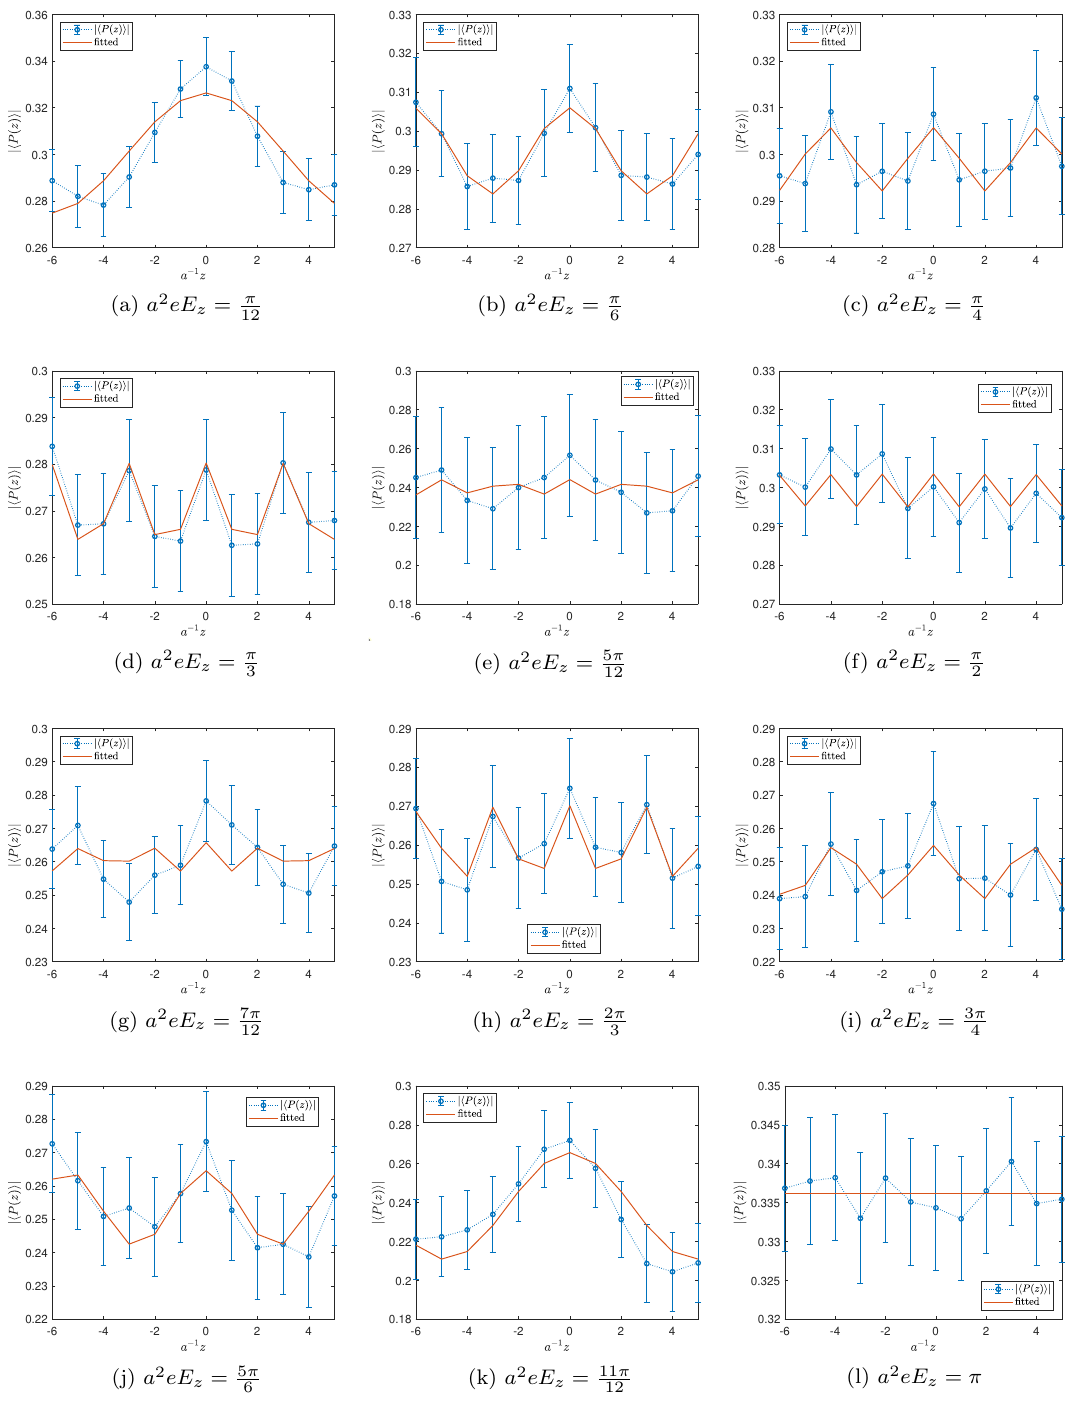
Figure 26 . Same as figure 6 but for |h P ( z ) i| at β = 5 . 64